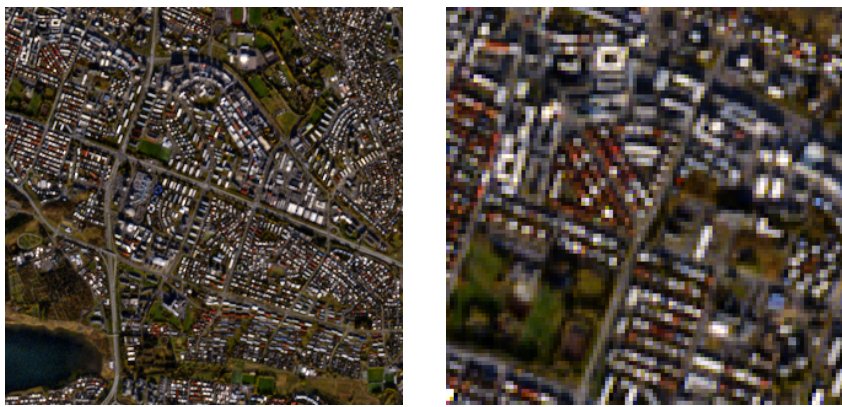
Figure 3. An RGB image generated [52,53] using an S2 image of central Reykjavik, Iceland. A crop in the upper left corner of the image, shown on the right, is used in Figures 4 and